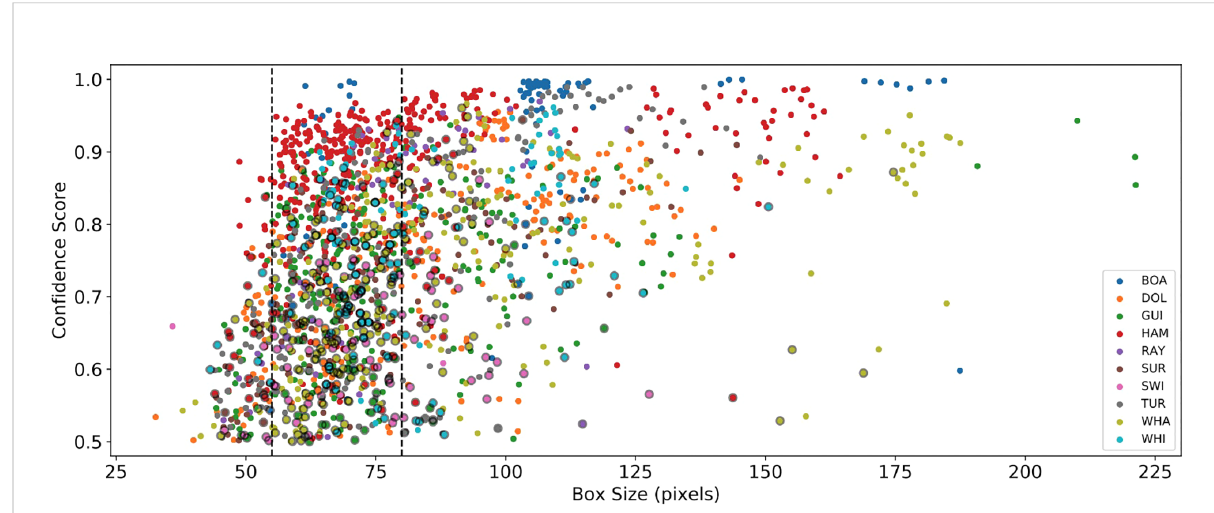
FIGURE 12 Plot showing the relationship between detection con fi dence score and object size (geometric average of the annotation box size) for the best- fi tting MobileNet V1 model. Detection con fi dence drops rapidly below a box size of ∼ 55 pixels, falling below the con fi dence threshold sthresh = 0.5 at a size of ∼ 45 pixels. All classes follow a general relationship where larger objects have more con fi dent predictions. Markers for incorrect predictions are outlined in black, illustrating that the model tends to make mistakes on objects smaller than 80 pixels in